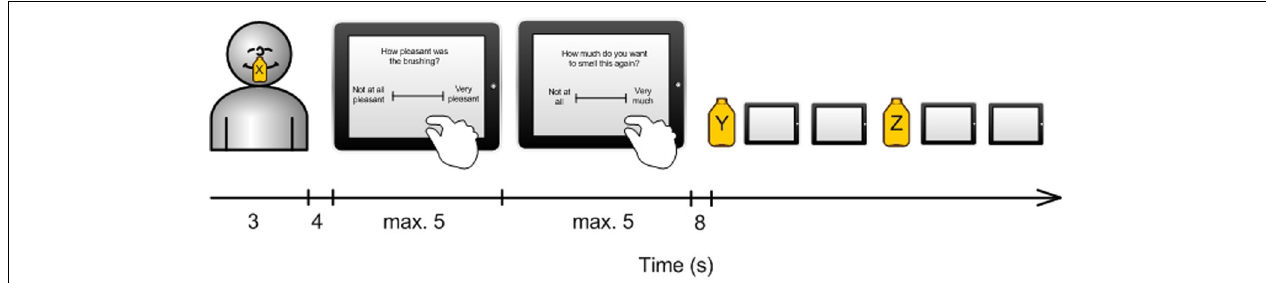
FIGURE 1 | Timeline of the experimental procedure. One trial consisted of the presentation of one smell and 2 subsequent rating scales (for explanation, see text).